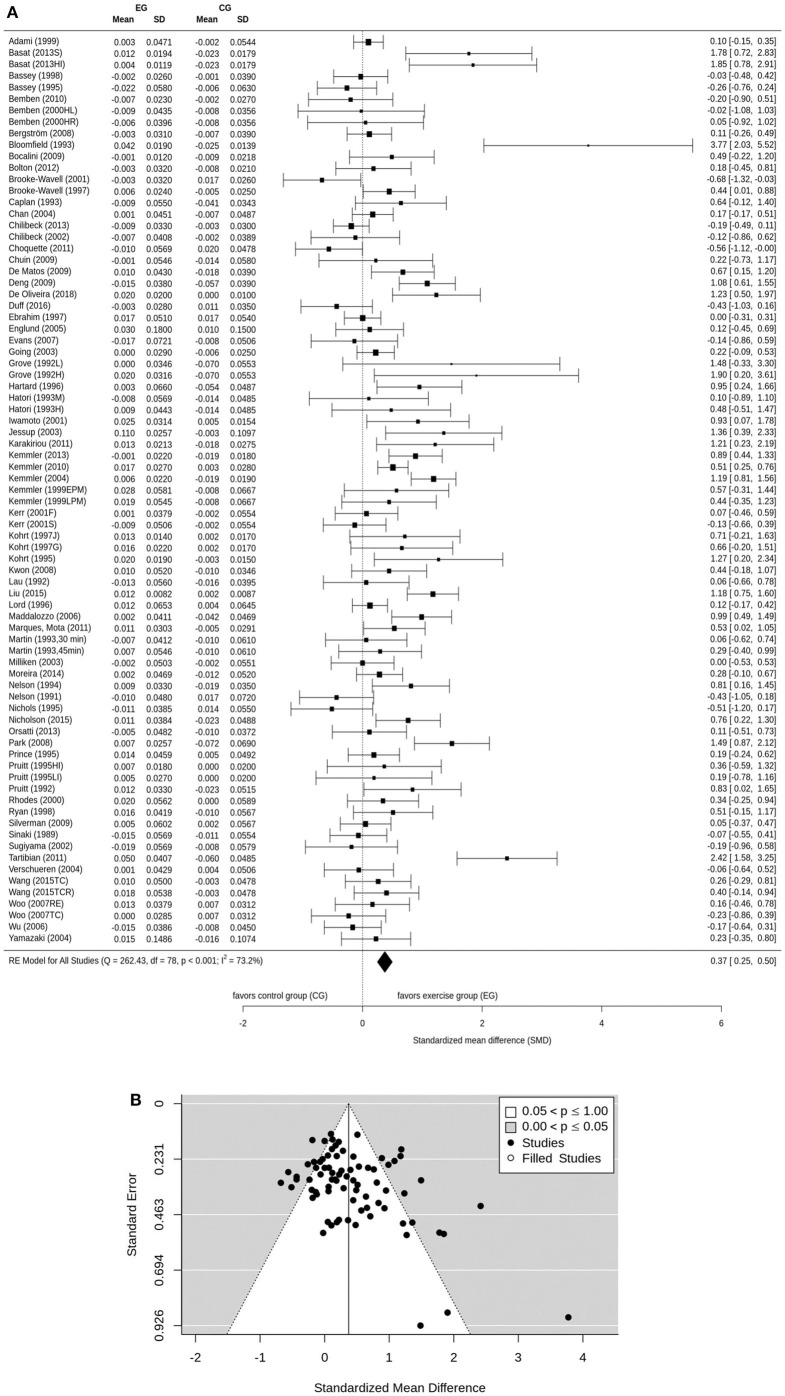
(A) Forest plot of meta-analysis results at the LS. The data are shown as pooled standard mean difference (SMD) with 95% CI for changes in exercise and control groups. (B) Funnel plot of LS BMD with Trim and Fill. SE, standard error of standardized mean difference; SMD, standardized mean difference.